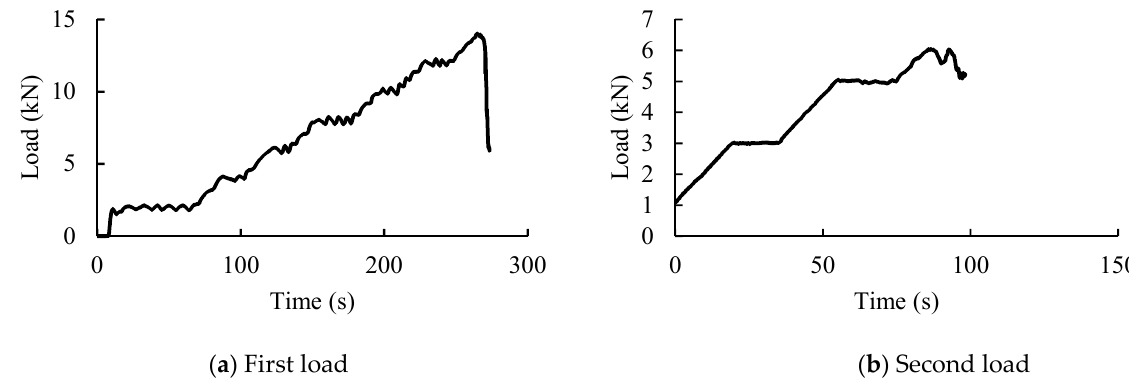
Figure 11. Loading curve of horizontal jack of Hp specimen. Table 3. The horizontal force of the test piece when the contact surface is paper base asphalt felt. Total Weight of Concrete